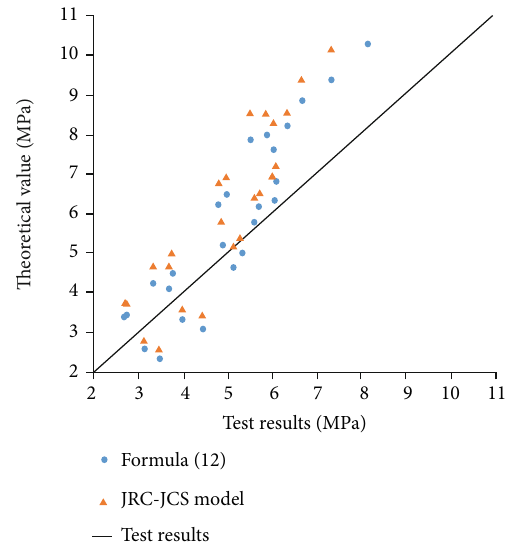
Figure 12: Comparison diagram of test results and theoretical value of the model.